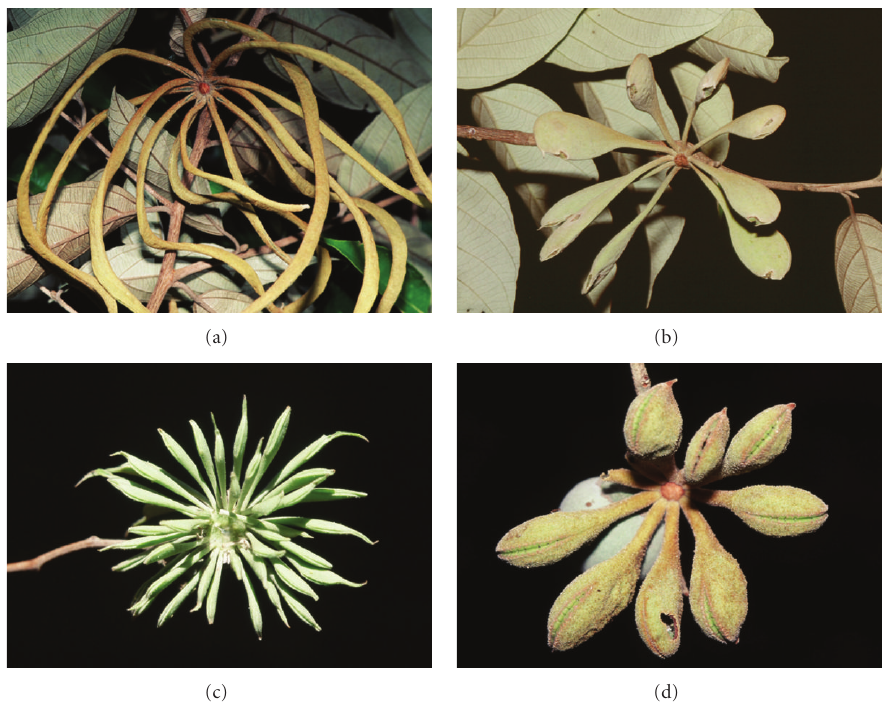
Figure 9: (a) A gall of Astegopteryx basalis on Styrax benzoin (Urung Tama, Sumatra; 21 August 1997). (b) A gall of Astegopteryx malaccensis on S. benzoin (Bukit Tinggi, Malay Peninsula; 31 March 1996). (c) A gall of Astegopteryx pallida on S. benzoin (Urung Tama; 1 August 1996). (d) A gall of Astegopteryx nipae on S. benzoin and a fruit of the host tree (Urung Tama; 1 August